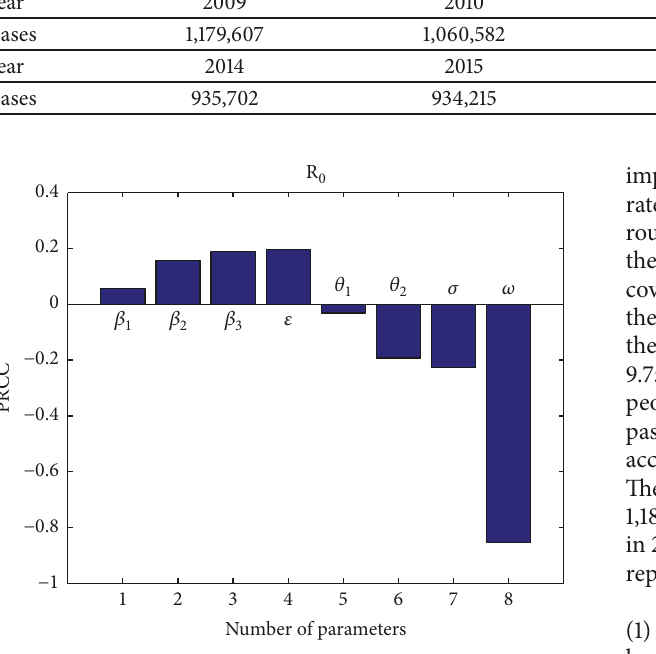
Figure 2: Sensitivity analysis for eight input parameters and outcome variable (the basic reproductive